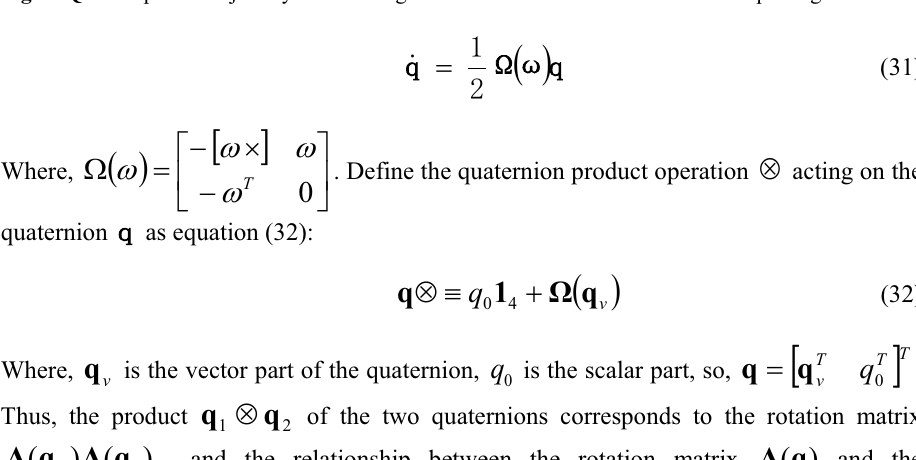
Fig. 1. QPSO optimal trajectory control diagram based on machine vision FFSR capturing NCT